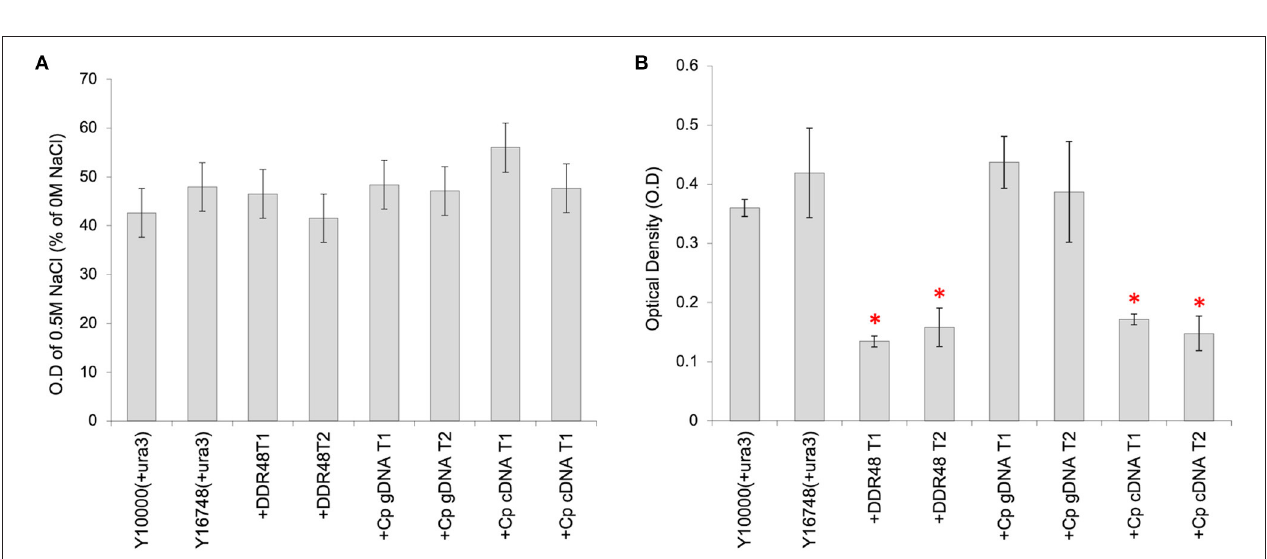
FIGURE 5 | Analysis of S. cerevisiae strains Y10000 (“WT”) and Y16748 ( 1 ddr48 ), as well as transformants highly expressing either DDR48 ( + DDR48) or Cprp gDNA ( + Cp gDNA) or cDNA ( + Cp cDNA). Two separate transformants were assessed for each construct (T1 and T2). Error bars represent the standard deviation of triplicates. (A) Response to salt stress as measured by the O.D of cultures supplemented with 0.5M NaCl, compared to cultures not supplemented. (B) Growth rate analysis, as measured by the O.D of cultures 16h after inoculation. All cultures contained 20% (w/v) galactose to induce expression from the pGAL1 promoter. * Denotes transformants which had growth rates that were significantly different to strain Y10000 ( + pYES2) (as determined by a two-tailed t -test. See Supplementary Table 3 for P